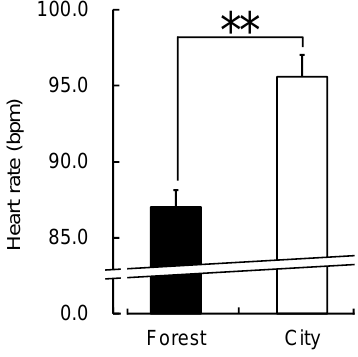
Figure 3. The natural logarithm of the heart rate variability low frequency/high frequency ratio while walking in forest and city areas. Data are presented as means ± standard error (n = 52). ** p < 0.01, paired t-test (one-sided).